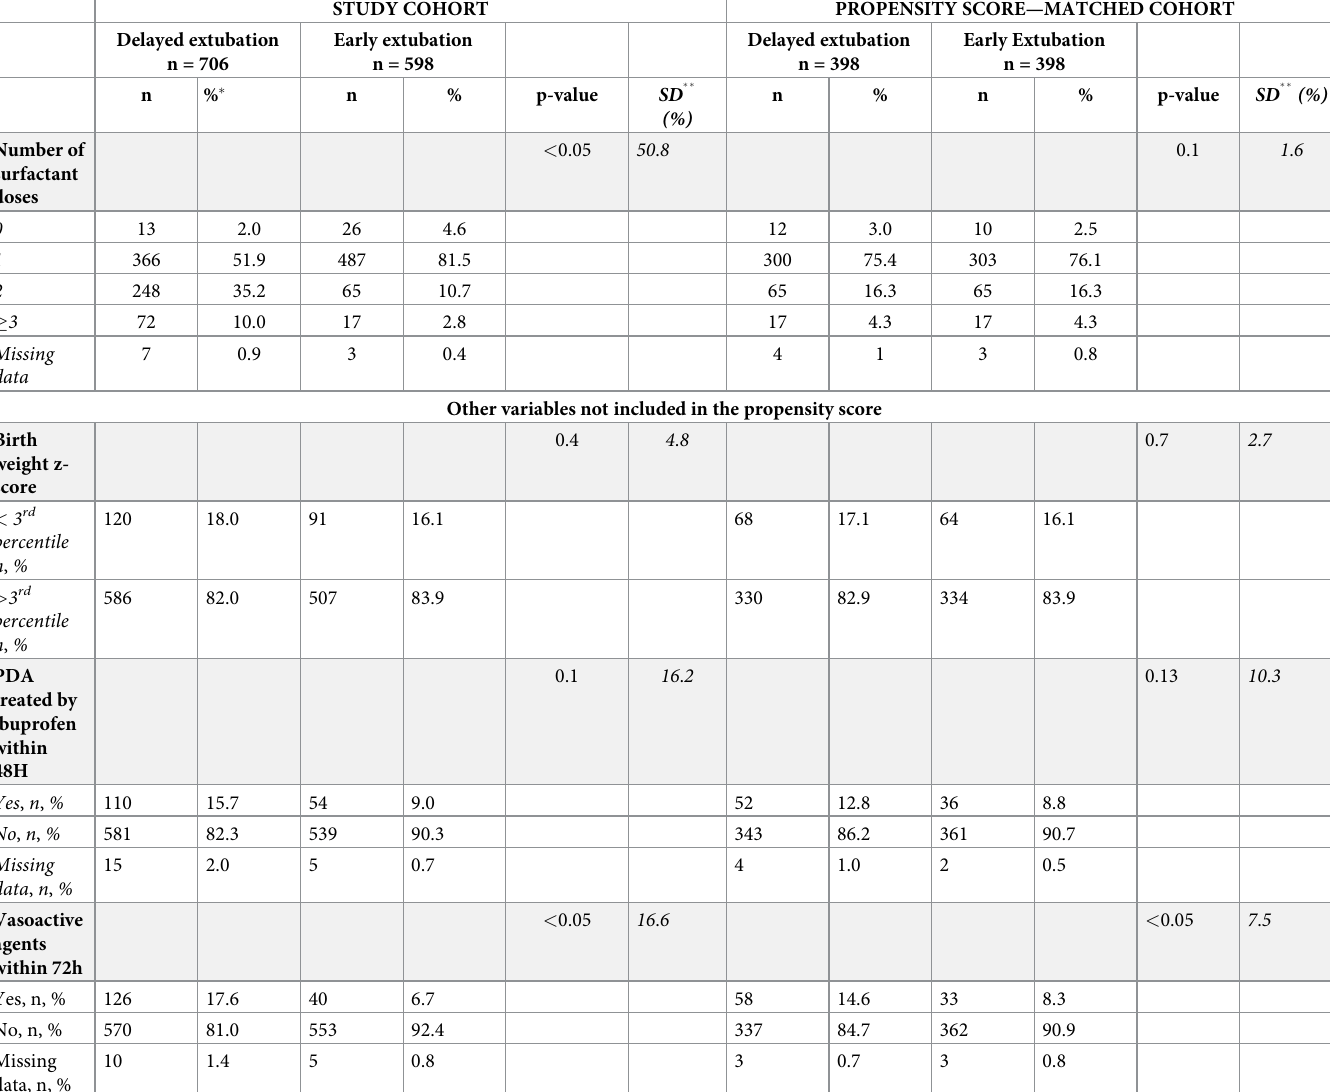
Table 2. Baseline variables according DE and EE within study cohort/ Propensity score-matched